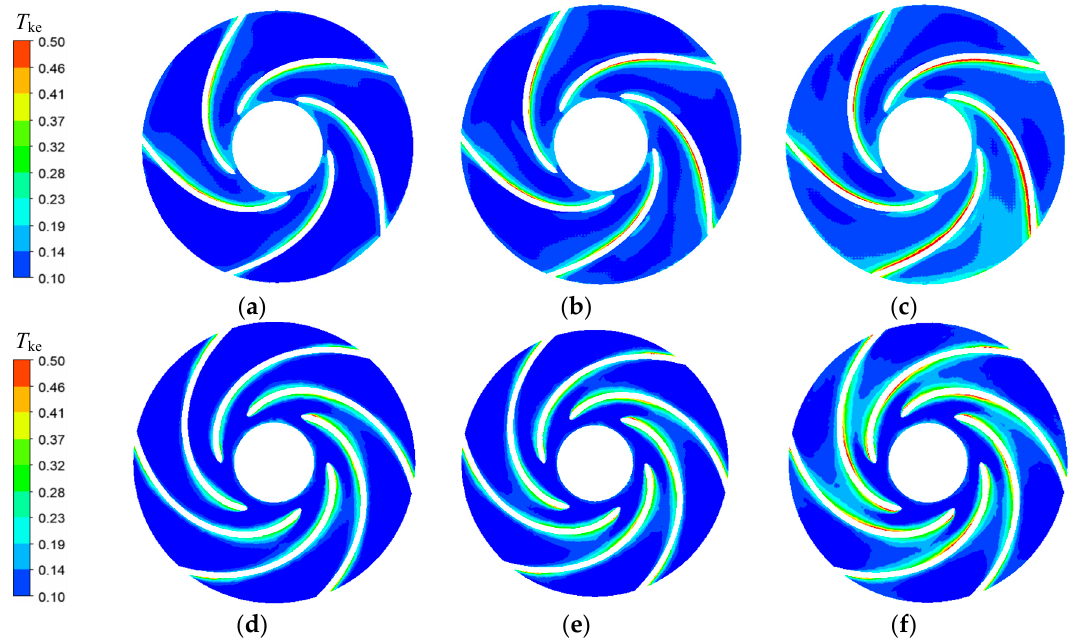
Figure 13. Comparison of turbulence kinetic energy in impeller for the two schemes: ( a ) origin, 0.8 Q d ; ( b ) origin, 1.0 Q d ; ( c ) origin, 1.25 Q d ; ( d ) optimization, 0.8 Q d ; ( e ) optimization, 1.0 Q d ; ( f ) optimization,